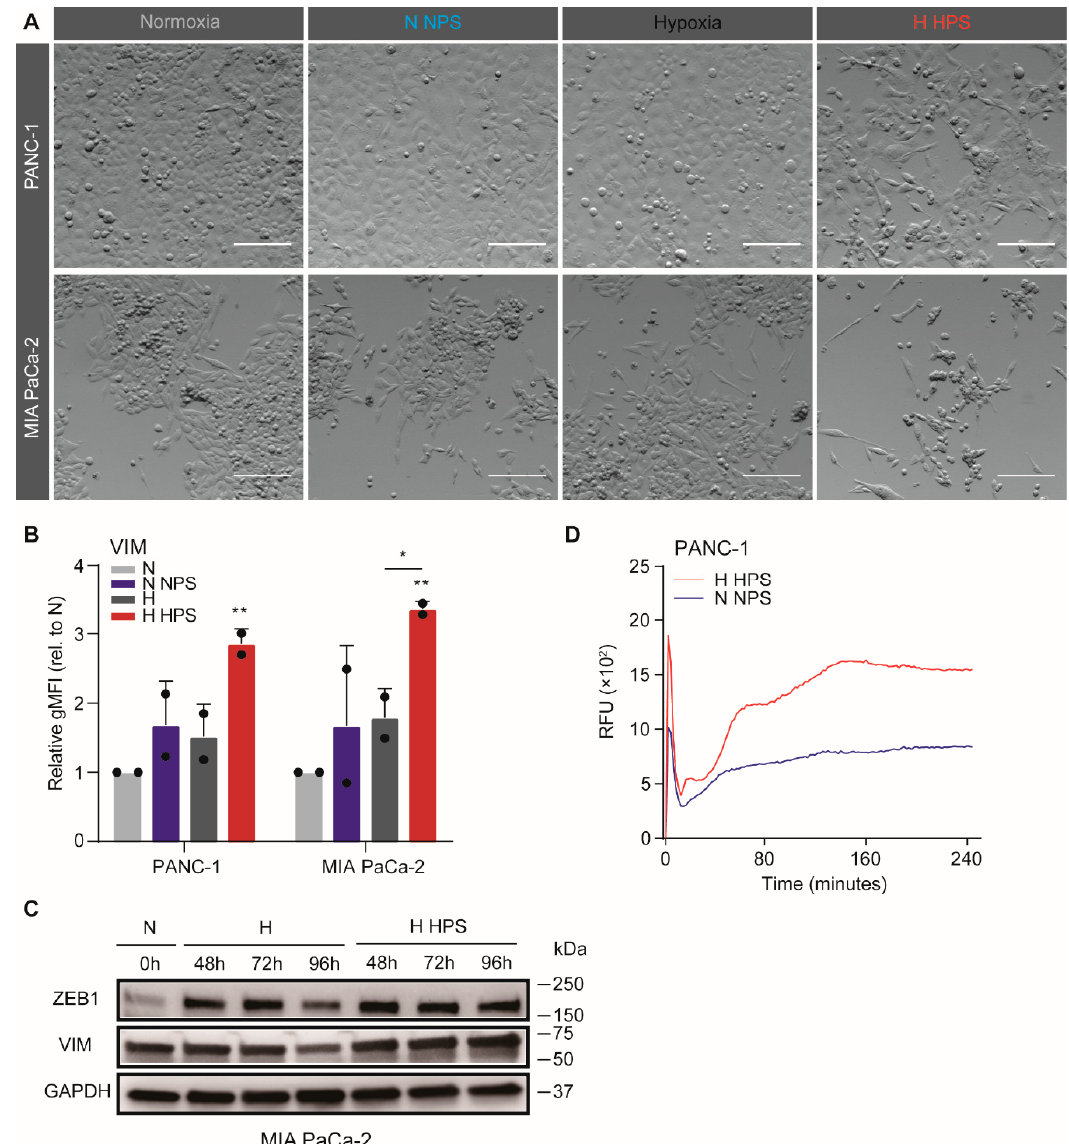
Figure 3. Soluble compounds released by hypoxia-activated stellate cells confer invasive phenotypes in tumor cells. ( A ) PS1 supernatant was harvested after 72-h hypoxia (or normoxia control) to generate hypoxic PS1 supernatant (HPS) and normoxic PS1 supernatant (NPS). Example images of PANC-1 (upper row) and MIA PaCa-2 (lower row) cells exposed to 3 days of NPS/DMEM under normoxia, or with HPS/DMEM under hypoxia (brightness and contrast of the photos were adjusted). Scale bar: 50 µm. ( B ) Expression of VIM in PDAC cells was measured by flow cytometry and values were normalized to normoxic unconditioned medium group. Data show the average gMFI ± S.E.M. (* p < 0.05, ** p < 0.01). ( C ) MIA PaCa-2 cells were incubated under conditions of H or H HPS for indicated times with normoxic incubation as a control. Cells were processed for Western blotting, using antibodies against ZEB1 and vimentin (VIM). GAPDH was used as loading control. ( D ) Transwell migration assays were performed on PANC-1 cells following treatments with NPS and normoxia, or HPS and hypoxia. 1% FCS was used as a chemoattractant. Migration curves are plotted with S.E.M. and corrected for no attractant controls (medium without FCS).